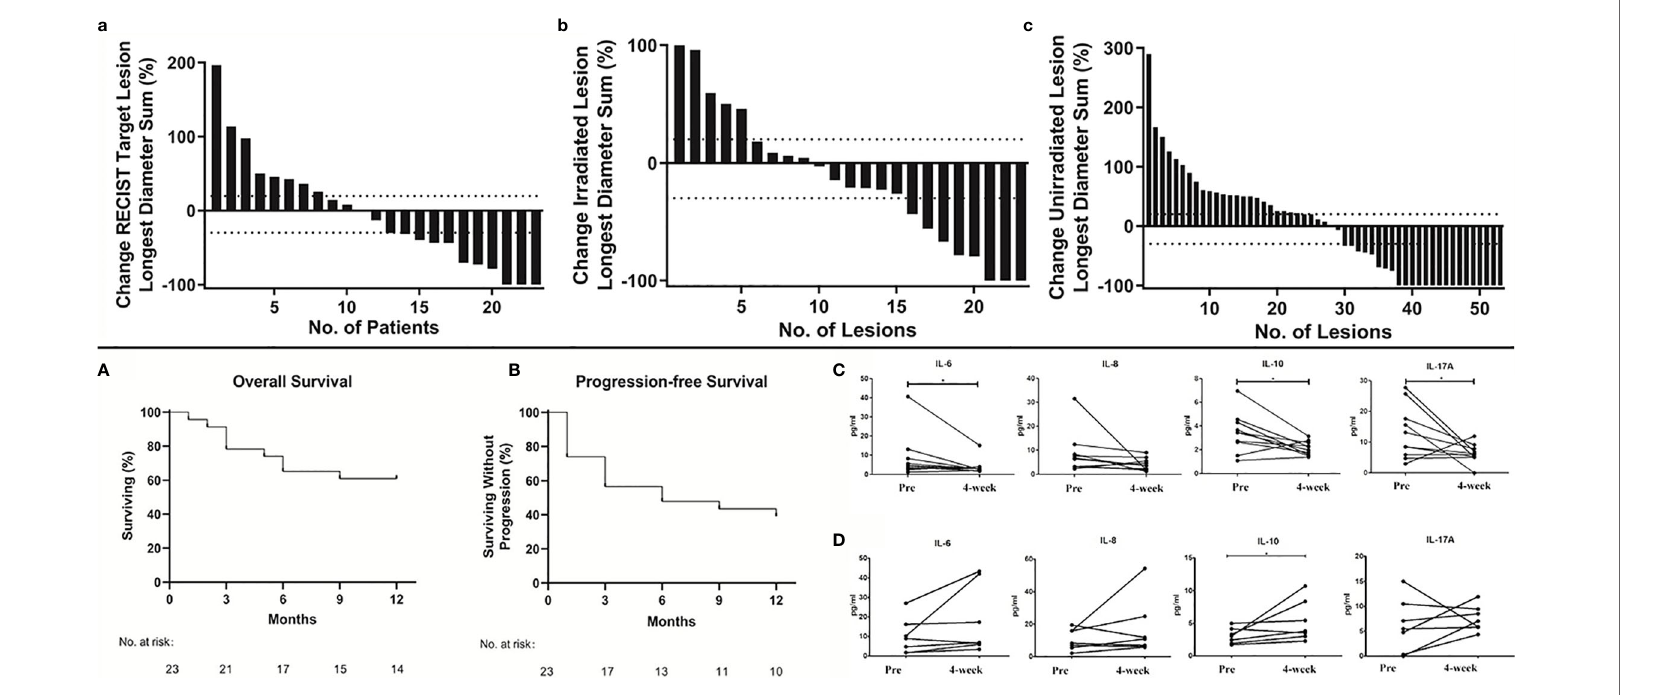
FIGURE 3 | Overall Treatment Response. Waterfall plots of best overall response. Maximum percentage change in the aggregate diameter of Response Evaluation Criteria in Solid Tumors target lesions (a) ; maximum percentage change in the aggregate diameter of irradiated lesions (b) and maximum percentage change in aggregate diameter of unirradiated target lesions (c) . Kaplan – Meier curves of 1-year overall survival (A) and progression-free survival (B) . Plasma IL-6, IL-8, IL-10, and IL-17A levels before and 4 weeks after nivolumab treatment in nivolumab responders ( C , n=10) and non-responders ( D , n=7). P values are calculated using the paired t-test, * P <